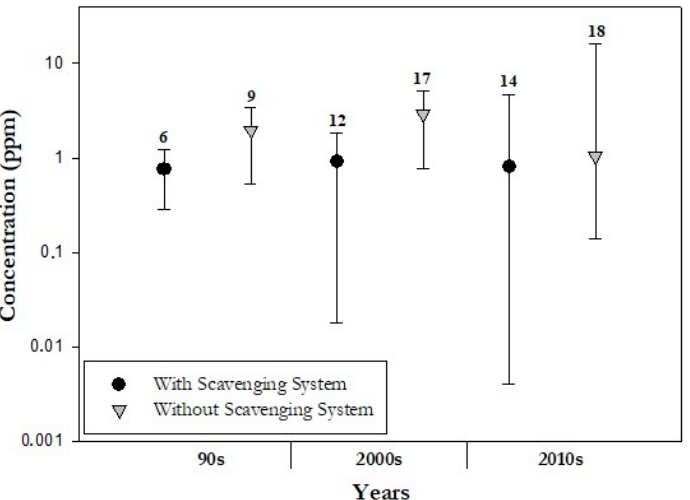
Figure 5. Median (circle and triangle), maximum and minimum (error bars) values of all three gases concentrations (sevoflurane, isoflurane and desflurane) with and without scavenging system, respectively. Divided in decades (1990s, 2000s, 2010s), number of studies considered per mitigation techniques of WAGs are shown.